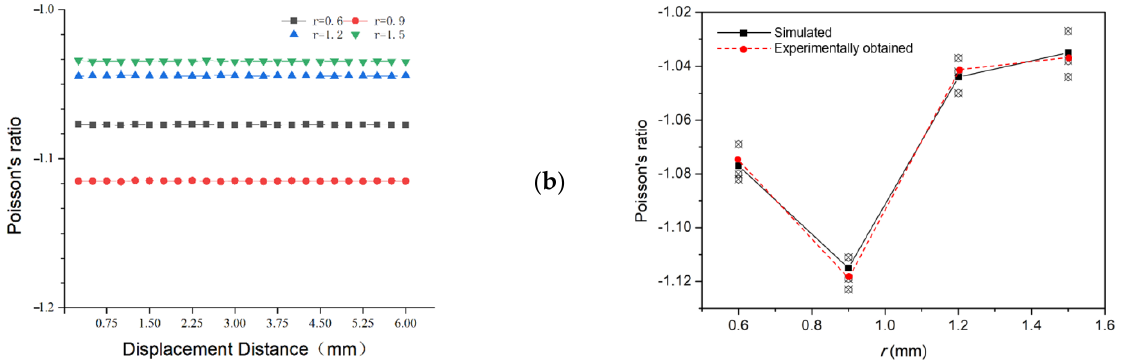
Figure 3. ( a ) Effect of node radius on Poisson’s ratio at the same displacement distance. ( b ) Comparison of experimentally obtained Poisson’s ratio with simulation results.